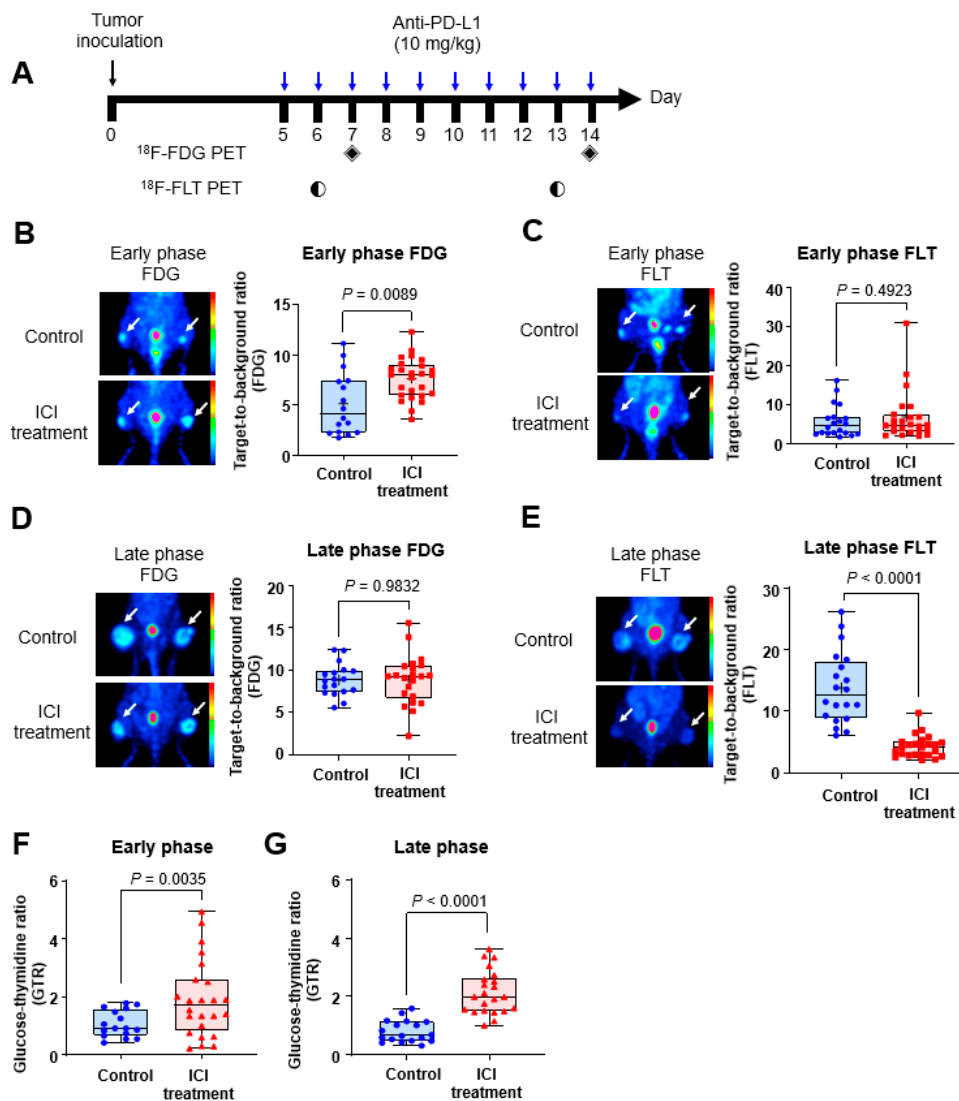
Figure 2. PET images in the early and late phases of ICI treatment. ( A ) Experimental design. 18 F-FDG and 18 F-FLT images were acquired in the early phases of ICI treatment (day 6, 7), and FDG and FLT images were acquired in the late phases of ICI treatment (day 13, 14). The black diamond symbols mean the day on which 18 F-FDG PET images were obtained, and the black circle symbols mean the day on which the 18 F-FLT PET images was acquired. The white arrow indicates the tumor uptake lesion. 18 F-FDG PET showed high TBR in the ICI treatment group in the early phase ( B ), whereas TBR by 18 F-FLT PET showed no difference in the early phase ( C ). In the late phase, there was no difference in TBR between the ICI treatment and control groups by 18 F-FDG PET ( D ), whereas 18 F-FLT PET showed a significantly low TBR in the treatment group ( E ). GTR was significantly higher in the ICI treatment group than the control group in both the early ( F ) and late ( G ) phases. In the graphs, the blue and red symbols represent data of each individual, and the black squares represent the data distribution.